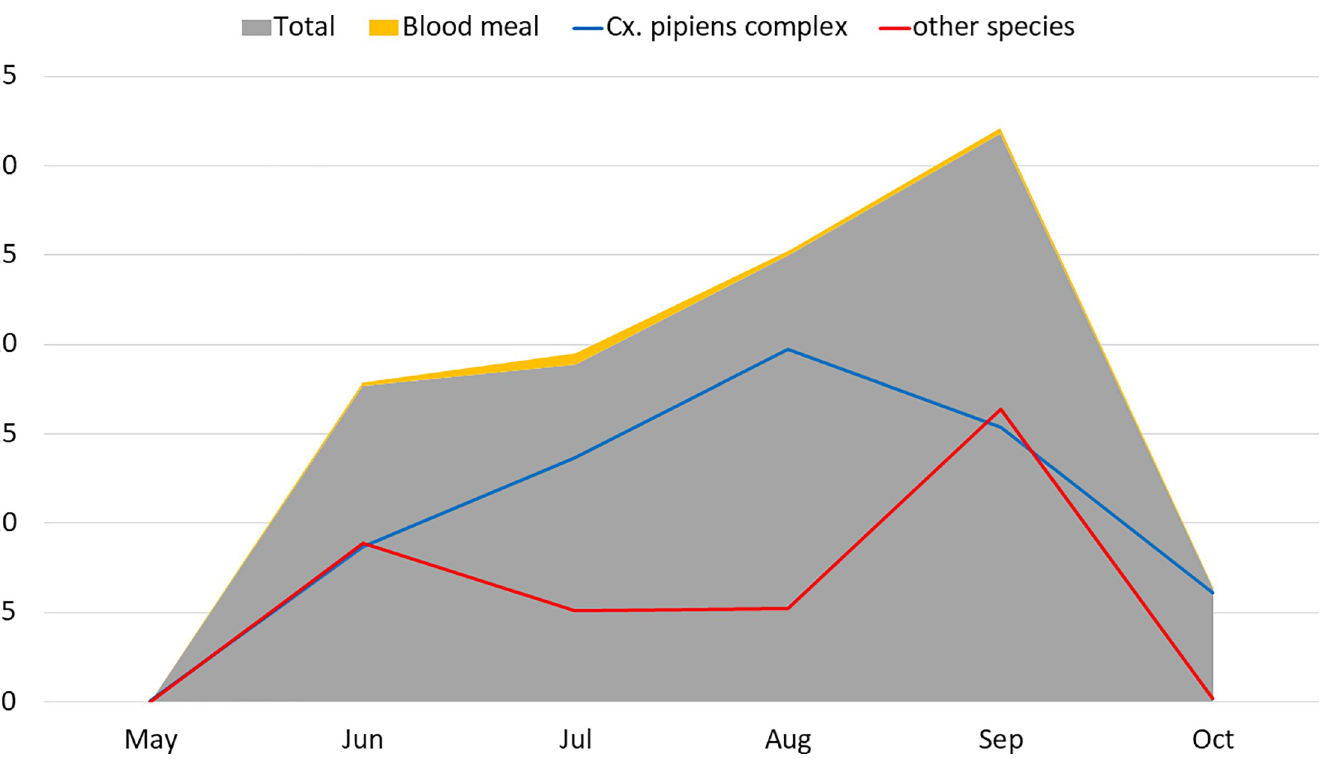
Fig 2. The percentage of total mosquitoes, blood-meals, Cx . pipiens complex and other mosquito species during trapping period in 2015 and 2016.